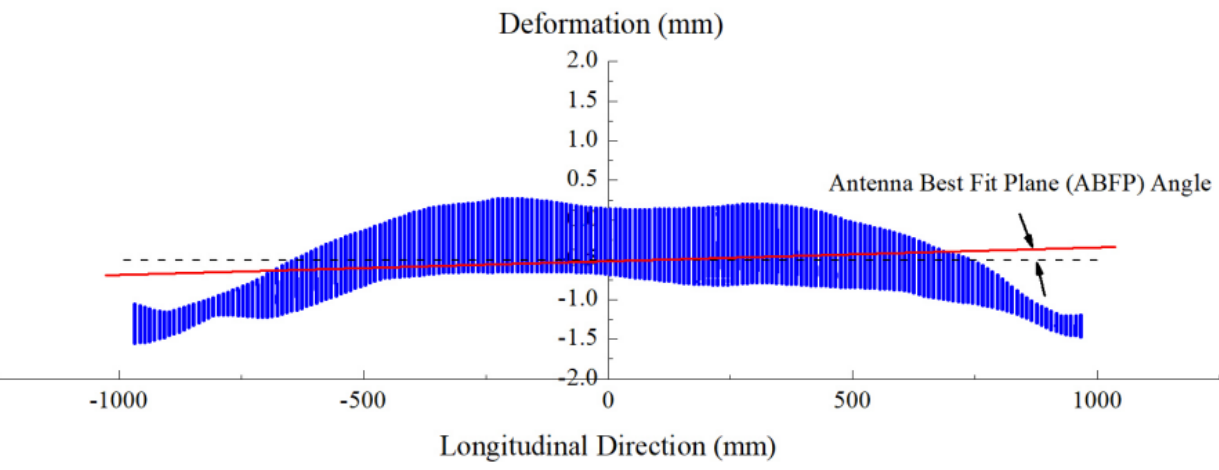
Figure 14. Thermal distortion of the SAR antenna under the worst thermal gradient condition.